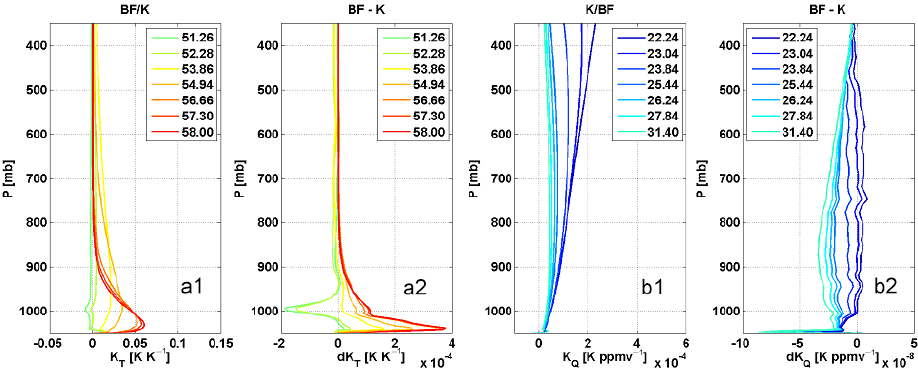
Figure 7. Jacobians calculated with the RTTOV-gb BF method and K-module. (a1) Temperature Jacobians for V-band channels; (b1) absolute humidity for K-band channels. Note that the BF method (solid line) and K-module (dashed line) are not distinguishable as they nearly completely overlap. Panels (a2, b2) show Jacobian differences between BF and K, for temperature and absolute humidity respectively.